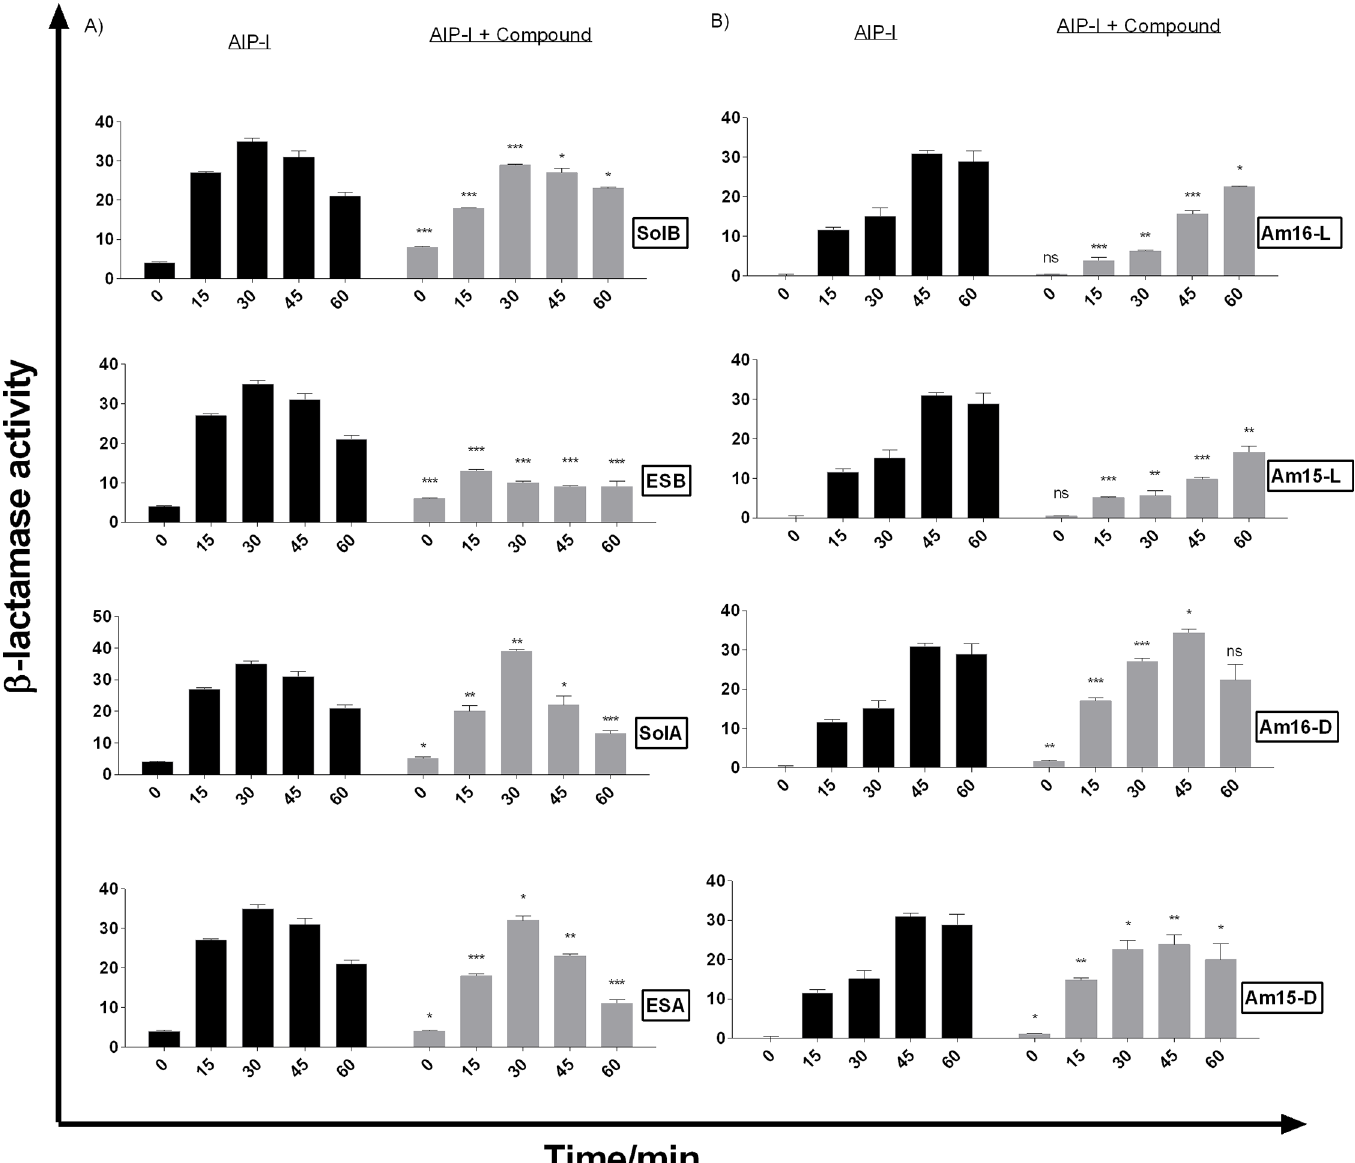
Fig 3. Solonamides (A) and lactam analogues (B) differentially interfere with AgrC activation as monitored by direct RNAIII expression. Cultures of RN10829 (P2-agrA:P3-blaZ) containing the pagrC-I-WT, were grown to an OD 600 of 0.4 – 0.5 where a 1/10 volume of AIP-I containing supernatant was added and solonamides and analogues in DMSO to a final concentration of 10 μ g/mL. Samples obtained at 15 min time intervals after addition of test solutions were analysed for β -lactamase activity. Each bar represents the average of 3 replicates and the error bars represent the standard deviation. Comparisons were made for each individual time point between AIP and AIP + Compound samples. ns (no significance); * , p < 0.05; ** , p < 0.01; *** , p <